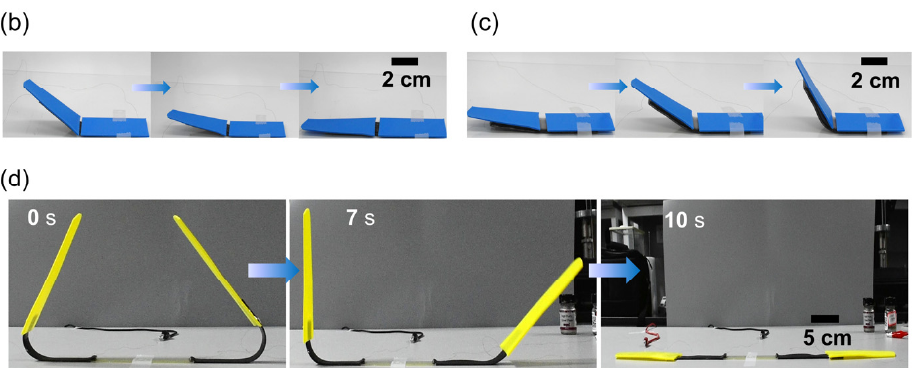
Figure 6. The shape recovery processes of GF-SMP structures. ( a ) Shape recovery of a 10 cm-long GF-SMP sample, ( b ) Unfolding of a GF-SMP joint structure, ( c ) Folding of a GF-SMP joint structure, ( d ) Unfolding of a 52 cm-long wing-like GF-SMP structure.